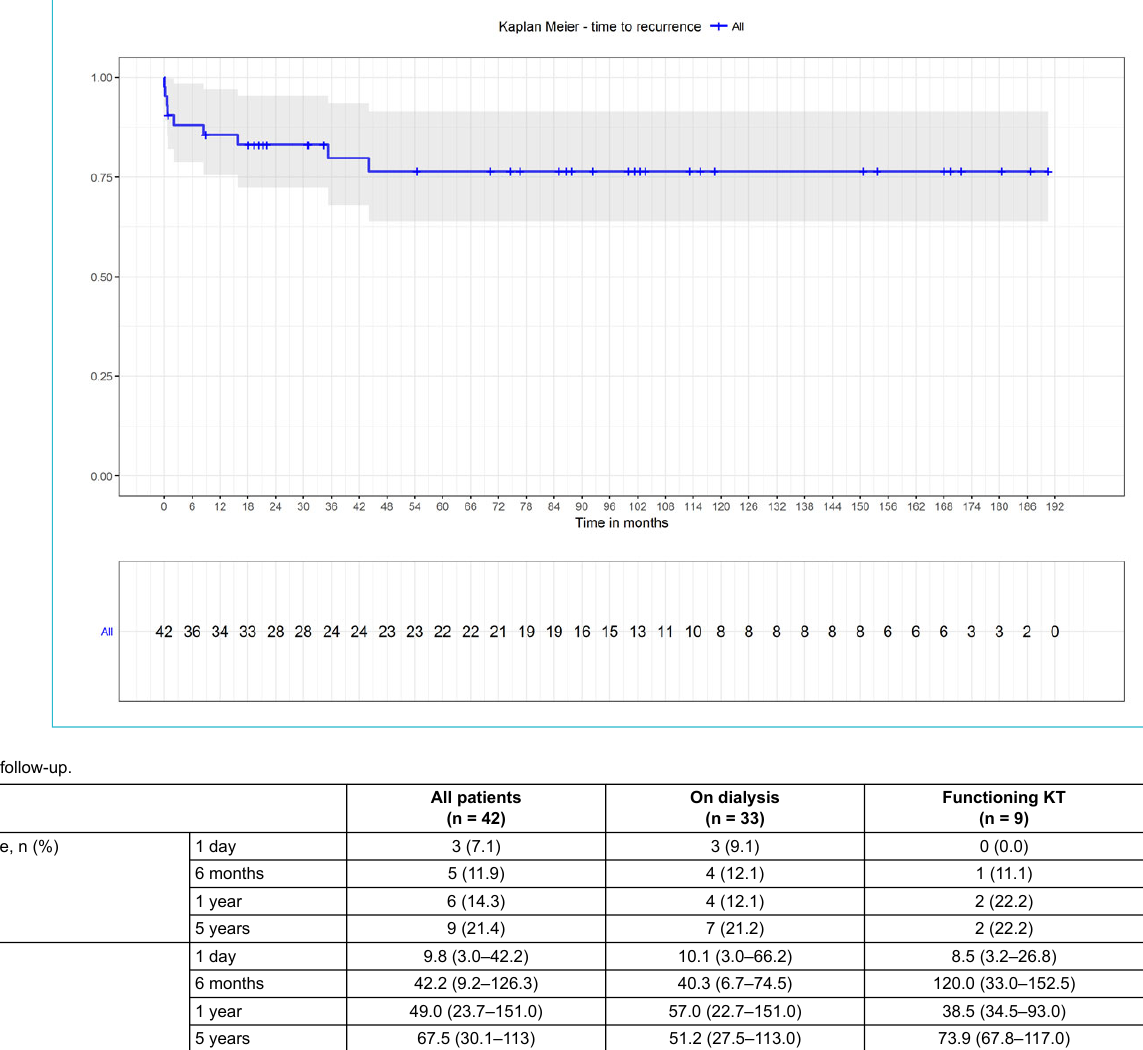
Figure 1: The Kaplan-Meier plot shows the probability of remaining recurrence free until a given point in time. The shaded areas represent the 95% confidence interval.